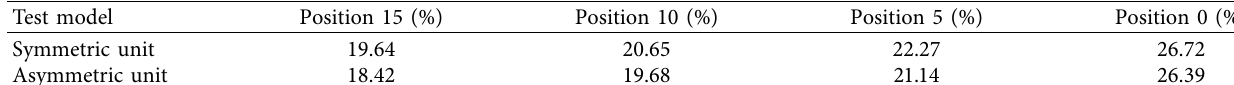
Table 2: Soil moisture content on the diagonal of the